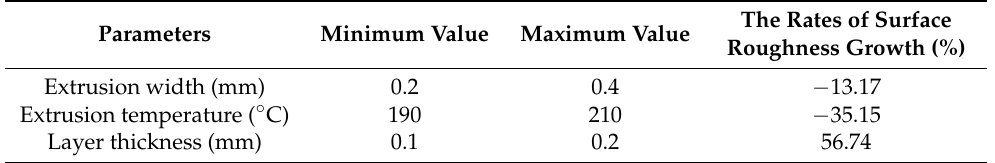
Table 8. The influencing degree of the three processing parameters.